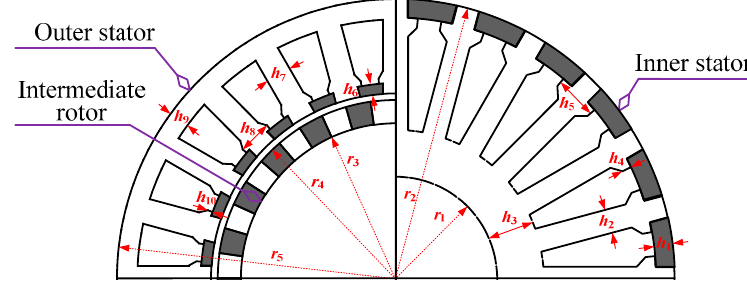
Figure 4. Dimension parameters of the TPMEV-DS machine.